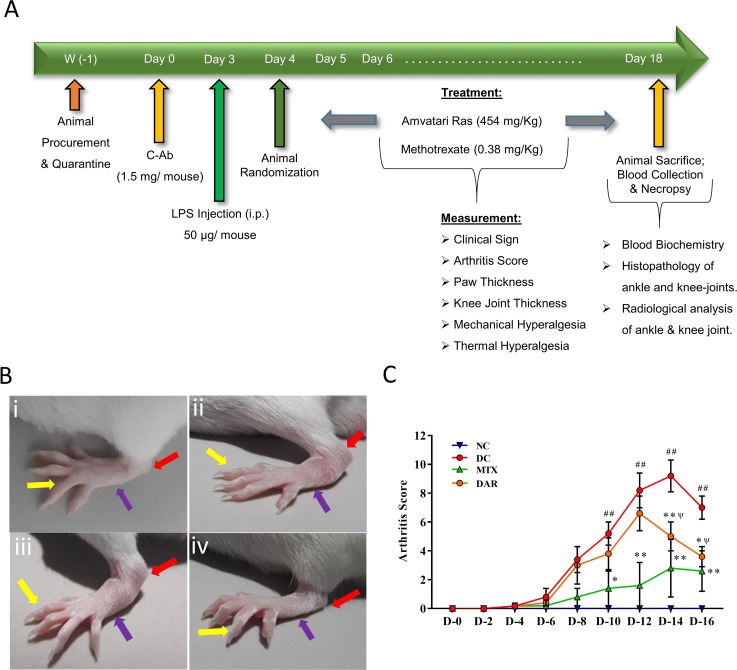
Induction of rheumatoid arthritis (RA) in Balb/C mice using collagen antibody (C-Ab) cocktail and modulation by DAR. (A) Male Balb/c mice were intraperitoneally treated with 1.5 mg/mouse dose of anti-collagen antibody (C-Ab) cocktail on day 0 and with 50 µg/mouse of bacterial lipopolysaccharide (LPS) on day 3. On day 4, all the animals were randomly assigned to the NC, DC, and treatment groups. The NC and DC animals were treated with sodium carboxymethyl cellulose (Na-CMC). The treatment group animals were given an oral dose of DAR (454 mg/kg) given every day for 2 weeks and standard reference drug Methotrexate (MTX; 0.38 mg/kg) given every alternate day for 2 weeks. Physical and clinical parameters were measured every day throughout the experimental duration. (B) (i) NC animal showed normal digits (yellow arrow), foot (blue arrow), and ankle (red arrow); (ii) development of digits, foot, and ankle edema in the DC animal; (iii) reduction of the digits, foot, and ankle edema in collagen antibody-induced arthritis (CAIA) mice treated with DAR; and (iv) MTX. (C) Arthritis score analysis showed an increase in arthritis scores in DC animals as compared to the NC animals. Treatment of the CAIA mice with DAR and MTX significantly reduced the arthritis score. Values in the results are mean ± SEM. A two-way analysis of variance (ANOVA) followed by Neuman–Newman–Keuls multiple-comparison test was used to calculate statistical difference on individual days in NC versus DC (p-value ## < 0.01), MTX or DAR treatment versus DC (p-value * < 0.05; ** < 0.01), and comparison between MTX and DAR treatments [p-value ψ > 0.05 (non-significant)].